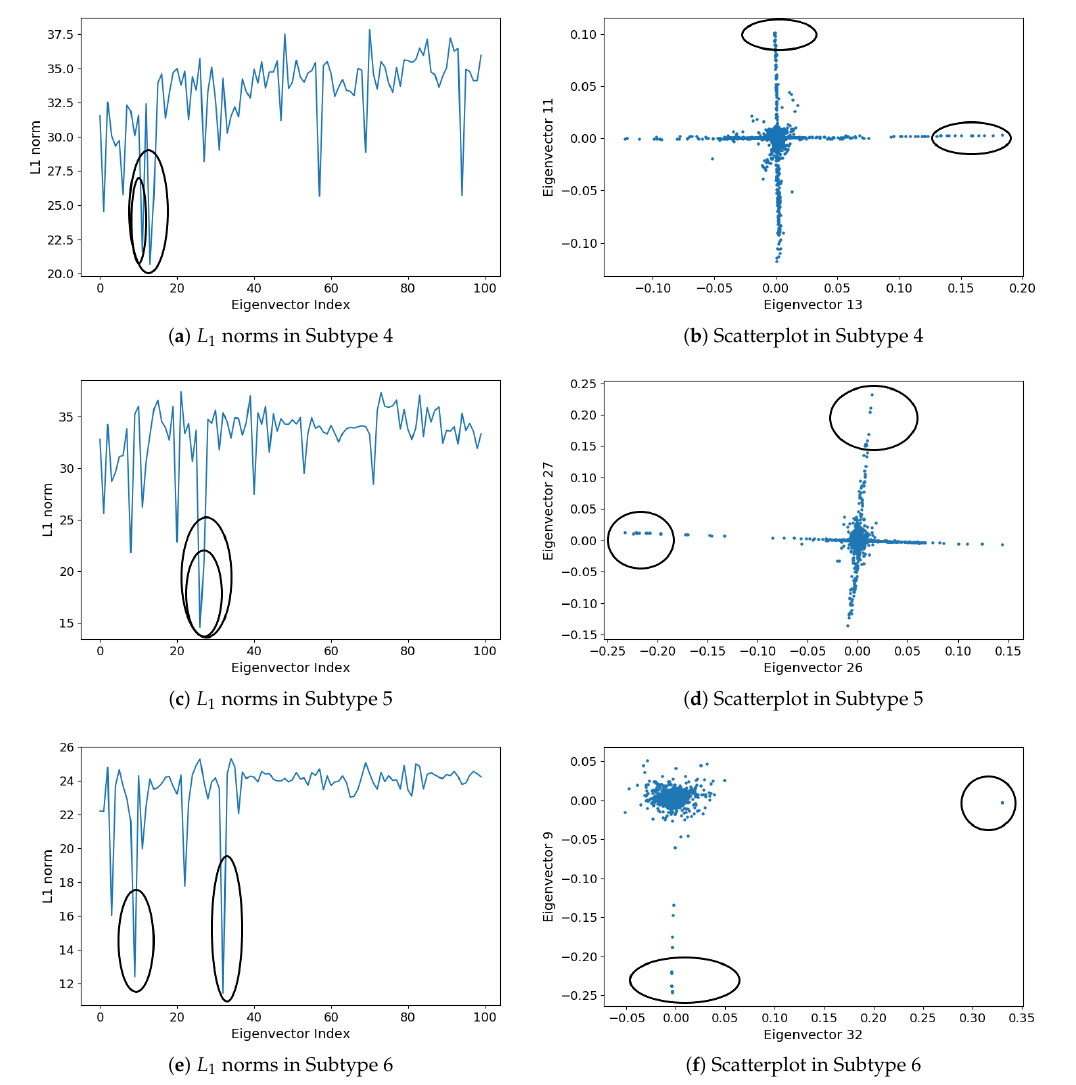
Figure 6. Eigenvector L 1 norms (left column): ( a ) L 1 norms in Subtype 4, ( c ) L 1 norms in Subtype 5, and ( e ) L 1 norms in Subtype 6. Scatterplots of the projection into the subspace defined by the indicated eigenvectors (right column): ( b ) Scatterplot in Subtype 4, ( d ) Scatterplot in Subtype 5, and ( f ) Scatterplot in Subtype